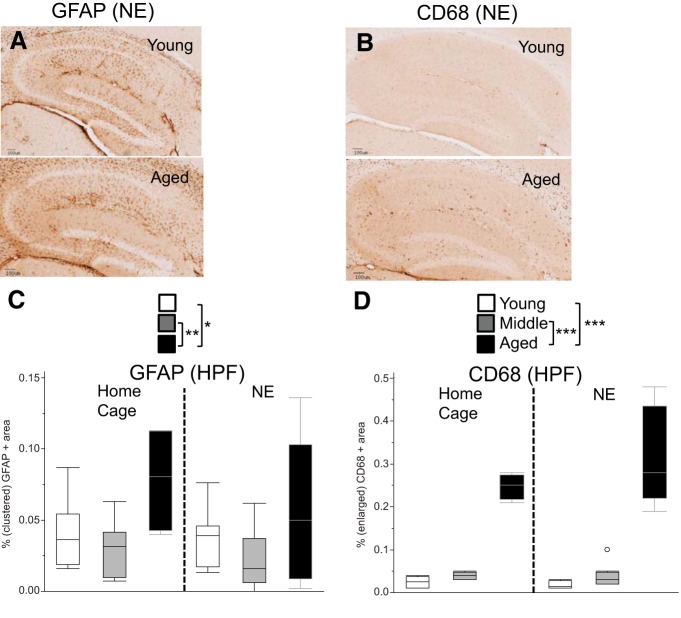
Markers of gliosis (GFAP, CD68) are increased in aged mice. A, B, Examples of brain slices showing areas of GFAP-positive (A) and CD68-positive (B) staining in the HPF are shown from the NE condition. C, The percentage of the total tissue area that had clustered GFAP-positive staining is shown. D, The percentage of the total tissue area from the HPF that had enlarged CD68-positive staining is shown. Values are expressed as box plots, as defined in the Data analysis section in Materials and Methods. *p < 0.05, **p < 0.005, ***p < 0.0001.